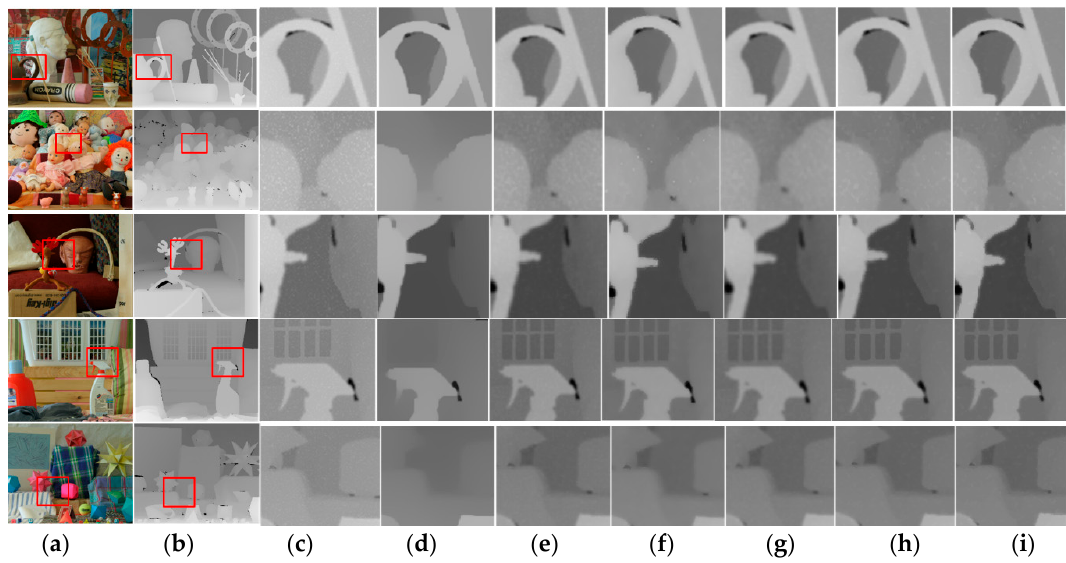
Figure 16. Results and comparison. ( a ) Original color images, ( b ) original depth map, ( c ) synthesized